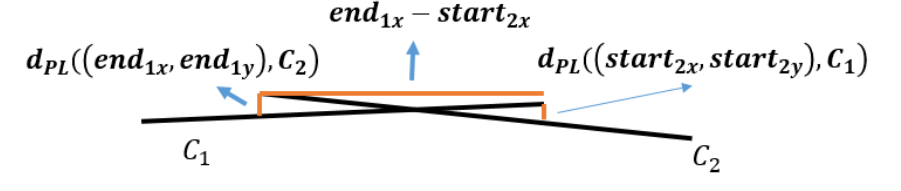
Figure 8. Overlapped